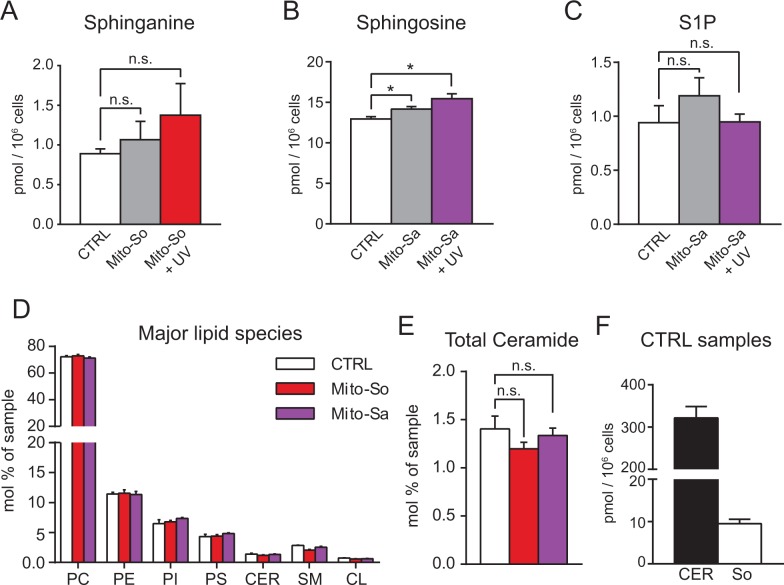
Lipid analysis of mito-caged probes in Hela cells.Sphinganine 1-phosphate (Sa-1P) levels were not plotted due to the low signals that cannot be separated from background. (A, B, C, F) Values were normalized with respect to the amount of C17 internal standards and cell numbers. (D, E) Values were normalized with respect to the amount of internal standards and were plotted as percentage of all lipid signals. (F) Total ceramides and sphingosine levels in DMSO controls; of note, the two lipid classes were extracted and detected using different protocols. Nevertheless, the data here provides an estimation and direct comparison of endogenous ceramides and sphingosine. Data represents the average of three independent experiments. Error bars represent SEM. *p<0.05, n.s., not significant, student's t-test.